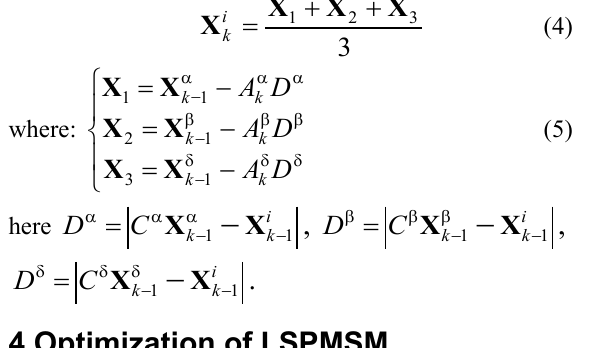
Table 1. The results of optimization